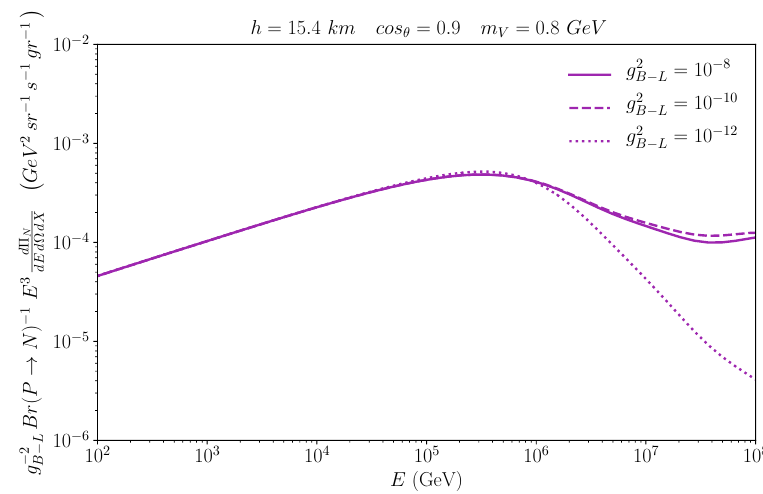
Figure 12 . N production from V decays in the B (cid:0) L model with m V = 0 : 8 GeV, m N = 0 : 35 GeV and for three values of g 2 . Note that because two N are produced in each decay we de(cid:12)ne B (cid:0) L Br( V ! N ) = 2Br( V ! NN